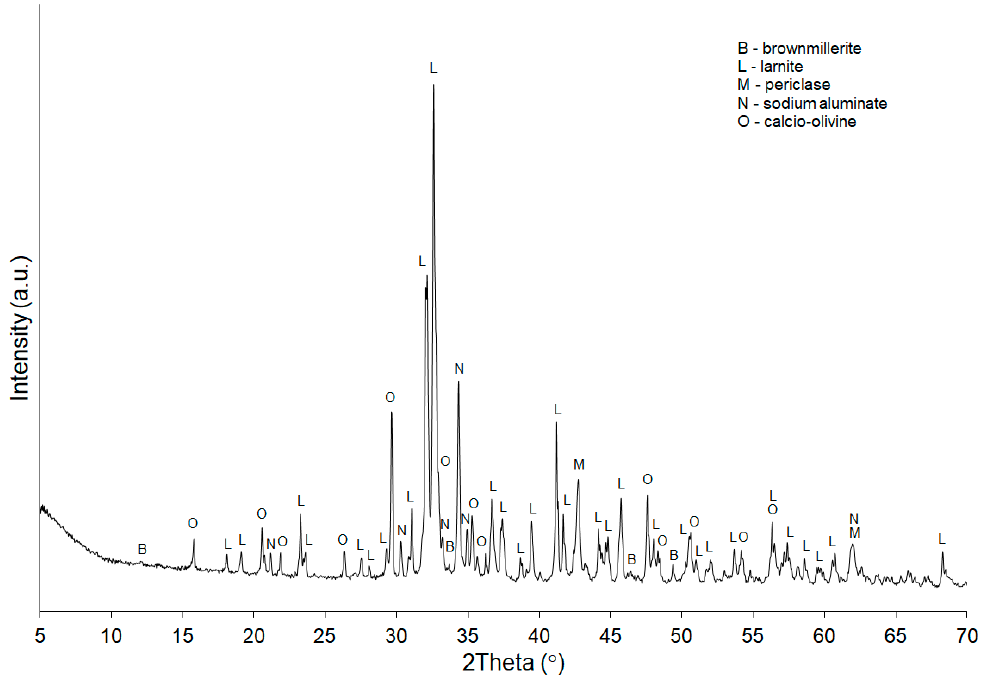
Figure 3. XRD pattern of the material obtained after the melting process.